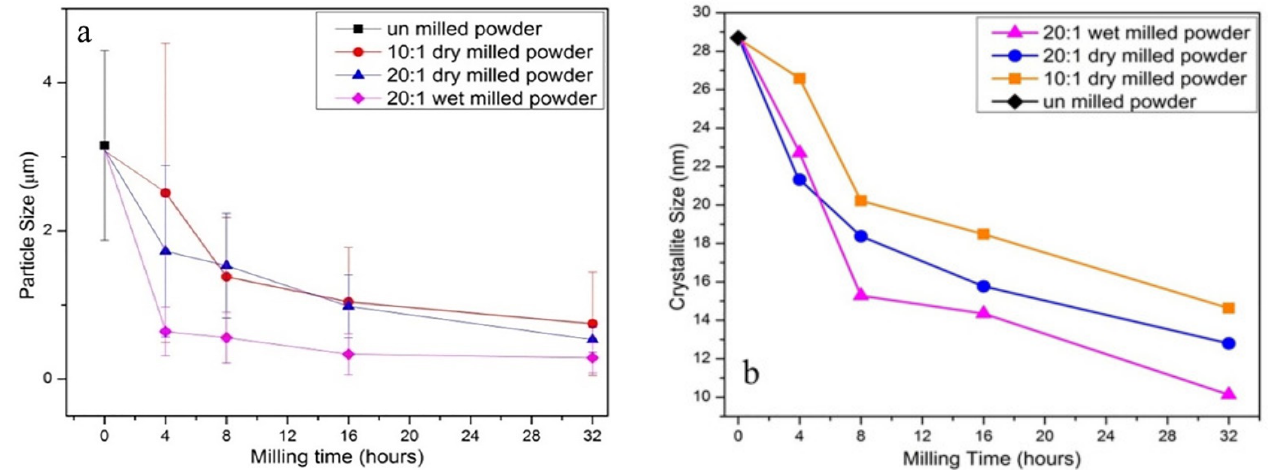
Figure 22. Particle size of plate-like alumina powders ball-milled with different parameters ( a ) and comparison of crystallite size ( b ). Reprinted with permission from [220]. Copyright 2021 Elsevier.